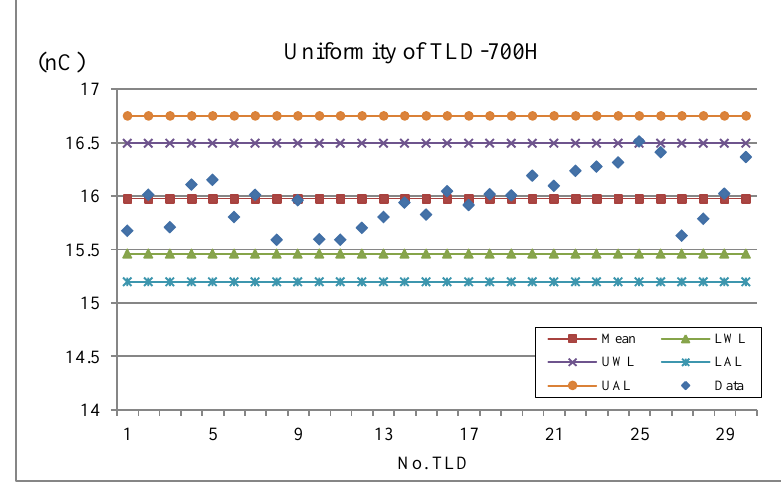
Figure 5a. Uniformity of TLD-700 against 90 Sr (1)